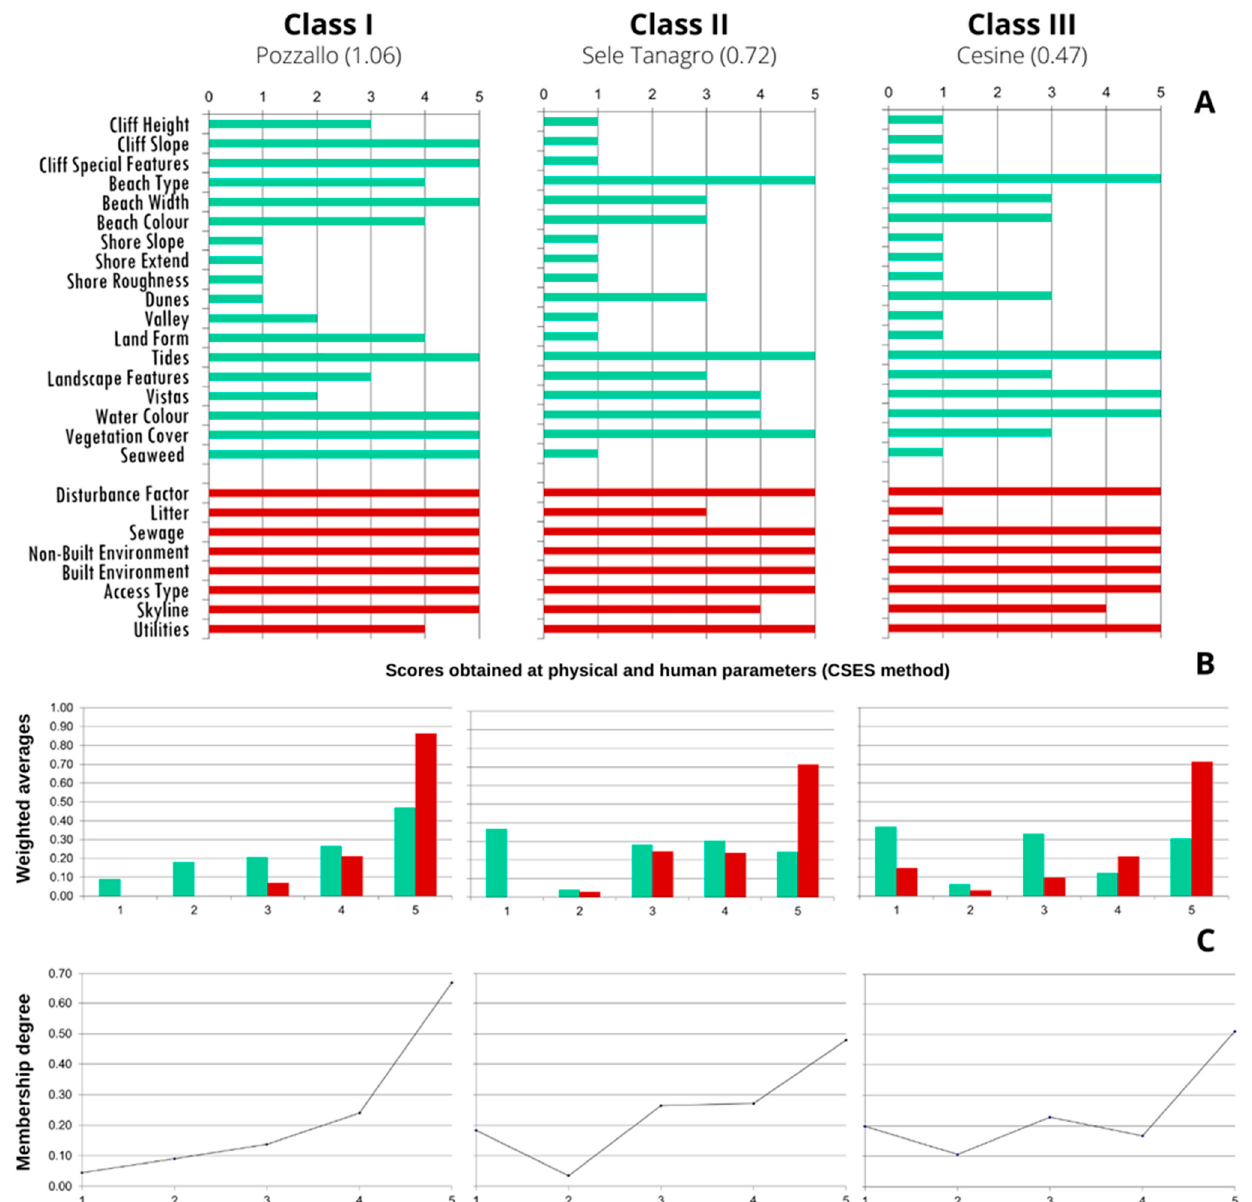
Figure A1. Scenic evaluation histograms ( A ), weighted averages ( B ) and membership degree curves ( C ) for Pozzallo (D: 1.06, Class I), Sele-Tanagro (D: 0.72, Class II) and Cesine (D: 0.47, Class III). A look at the weighted average figure instantaneously points out the potential ranking of the scenic evaluation, as well as a membership degree curve rising to the right reflects a high landscape quality due to the low rating on attributes 1 and 2 (and vice versa for a left-skewed curve).